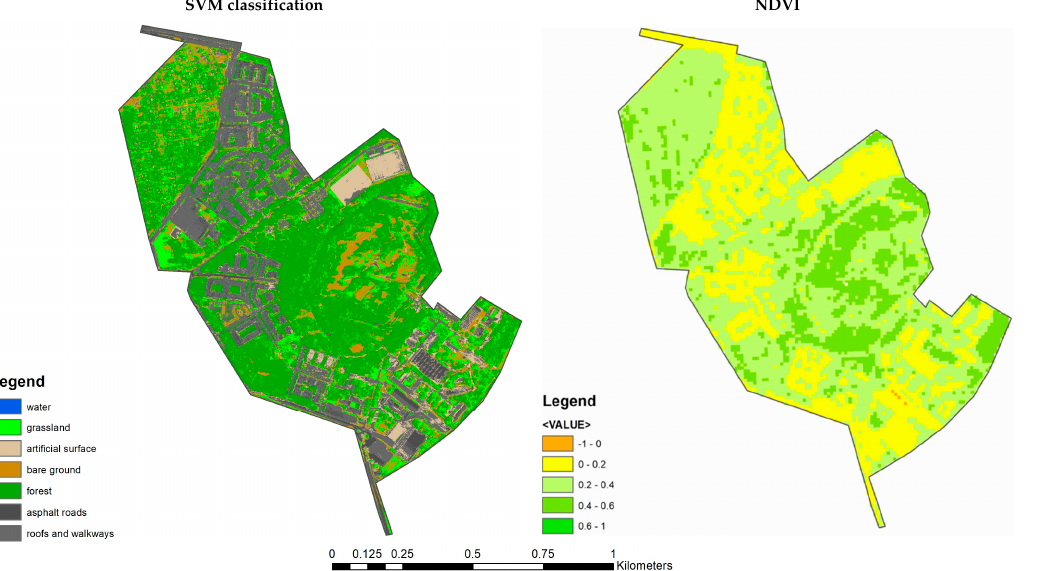
Figure 8. Classification with the SVM and visualization of vegetation production (representative of the permeable surface) with NDVI methods [source: own elaboration based on data from SENTINEL—10 m resolution, satellite images are from 9 May 2022, and data were downloaded from Earth Explorer (https://earthexplorer.usgs.gov, accessed on 2 November 2022)].